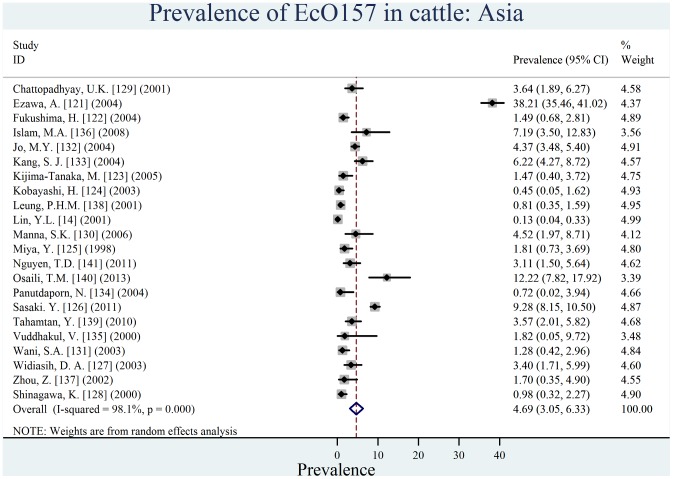
Forest plot of prevalence of E. coli O157 in cattle amongst studies conducted in Asia.